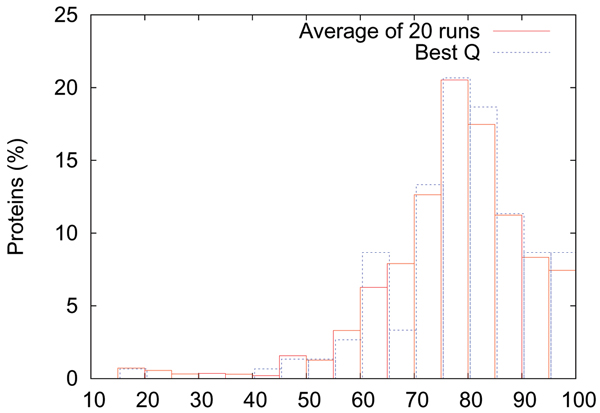
Qα accuracy histogram. Histogram showing the distribution of Qα across proteins in the test set. We have shown the average case, and the best of the 20 runs which has the highest Qα.